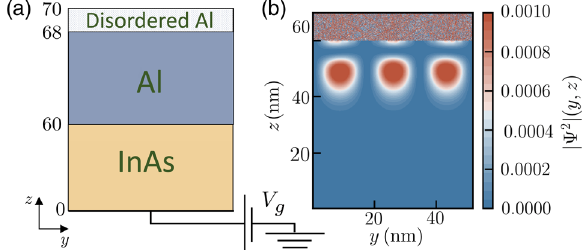
FIG. 14. (a) SM-SC heterostructure in the slab geometry in the presence of disorder on the surface of superconductor (not to scale). (b) Square modulus of the eigenstate in the presence of disorder highlighting the enhanced scattering in the superconductor.